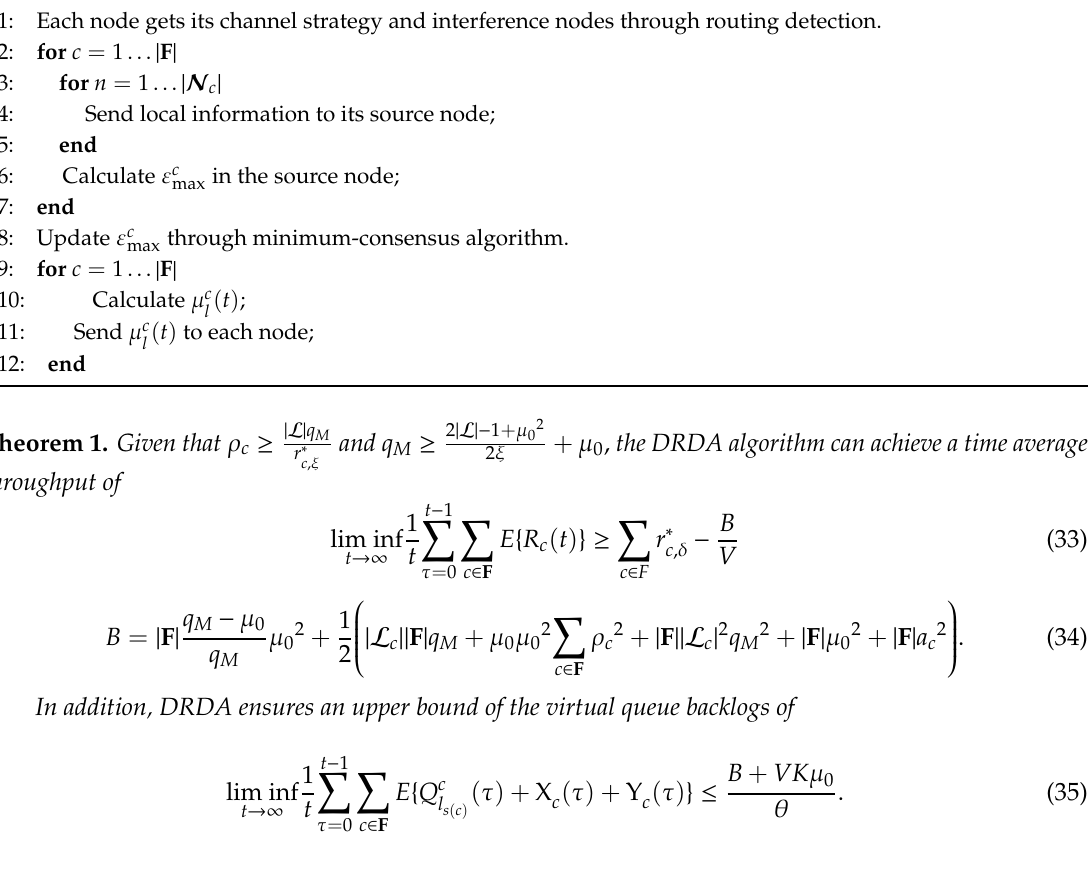
Algorithm 1: Distributed Rate